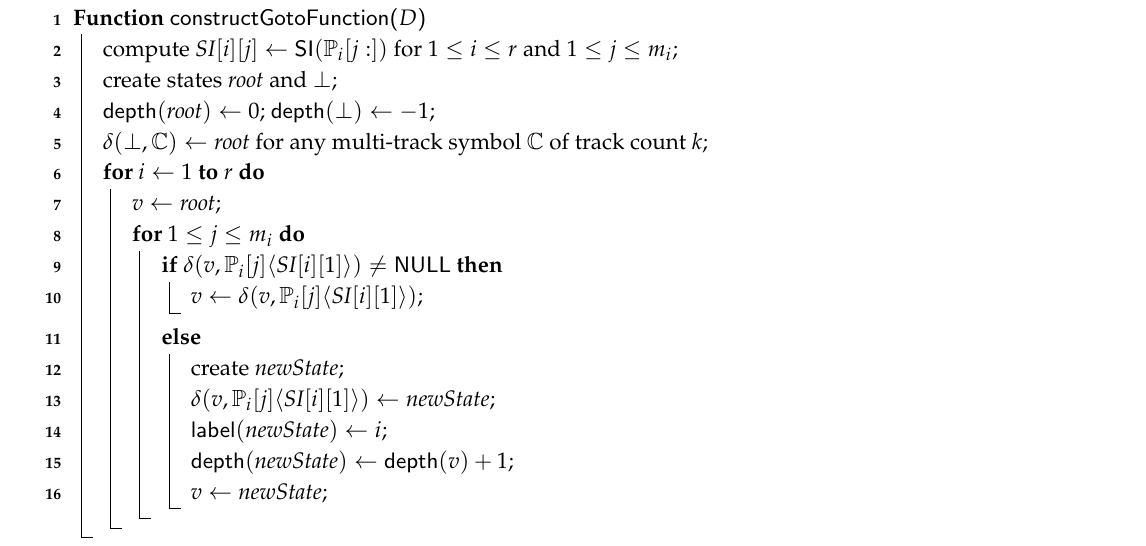
Algorithm 3: Multi-track AC-automaton goto function construction